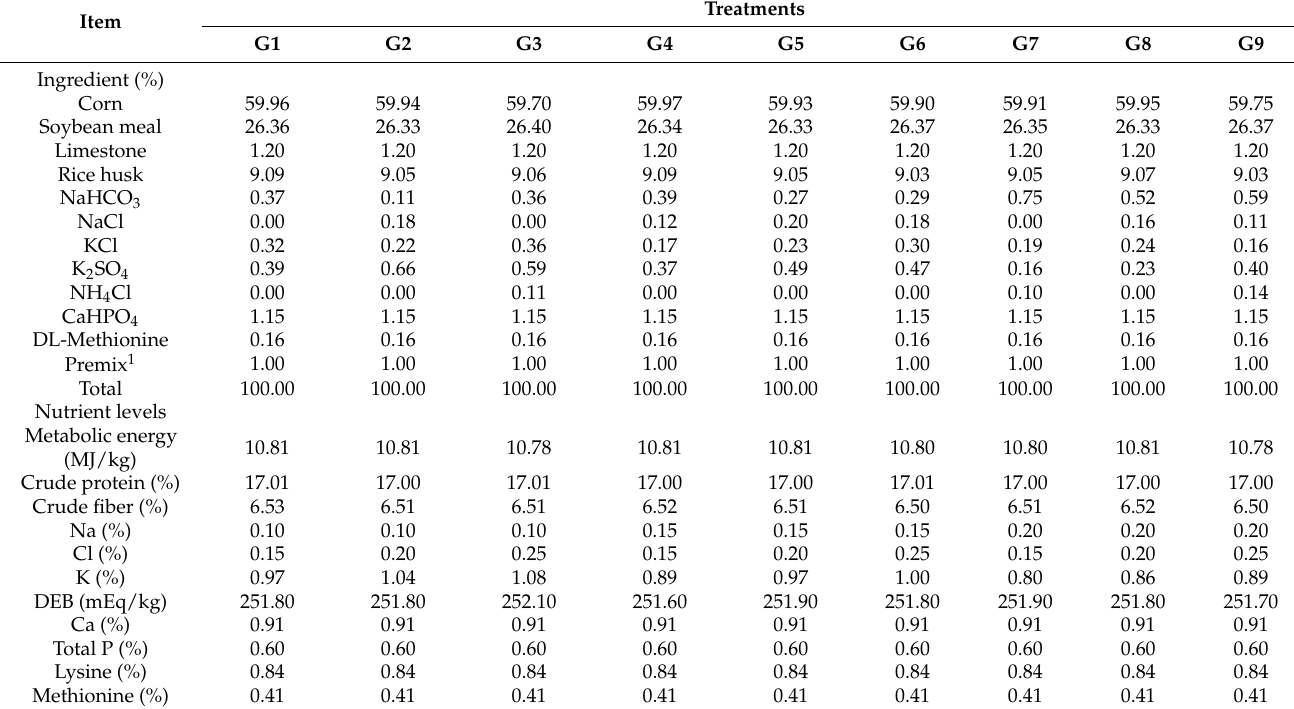
Table 1. Composition and nutrient level of experimental diet in geese (air-dry